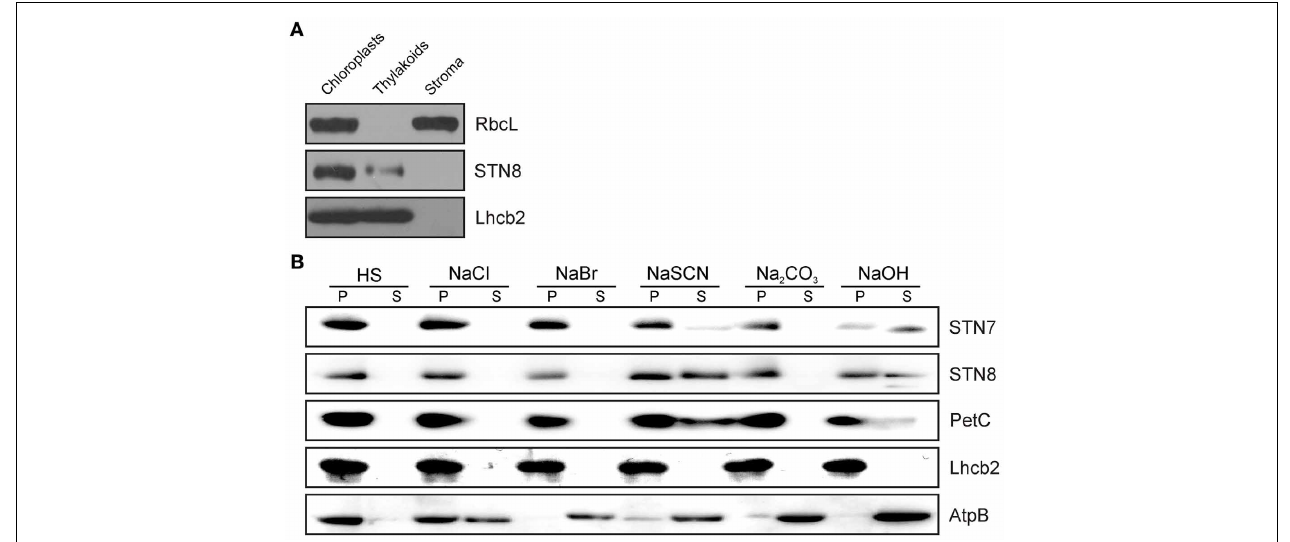
FIGURE 2 | Sub-organellar localization of STN8 and membrane association of the STN kinases. (A) Arabidopsis WT chloroplasts were fractionated into soluble and membrane components and subsequently separated by SDS-PAGE. After Western transfer, STN8, RbcL (stroma marker) and Lhcb2 (thylakoid marker) were detected using specific antibodies. (B) Extraction of membrane-associated proteins with alkaline buffers or chaotropic salt solutions. Thylakoid membranes from WT plants were resuspended at 0.5mg chlorophyll/mL in HS buffer